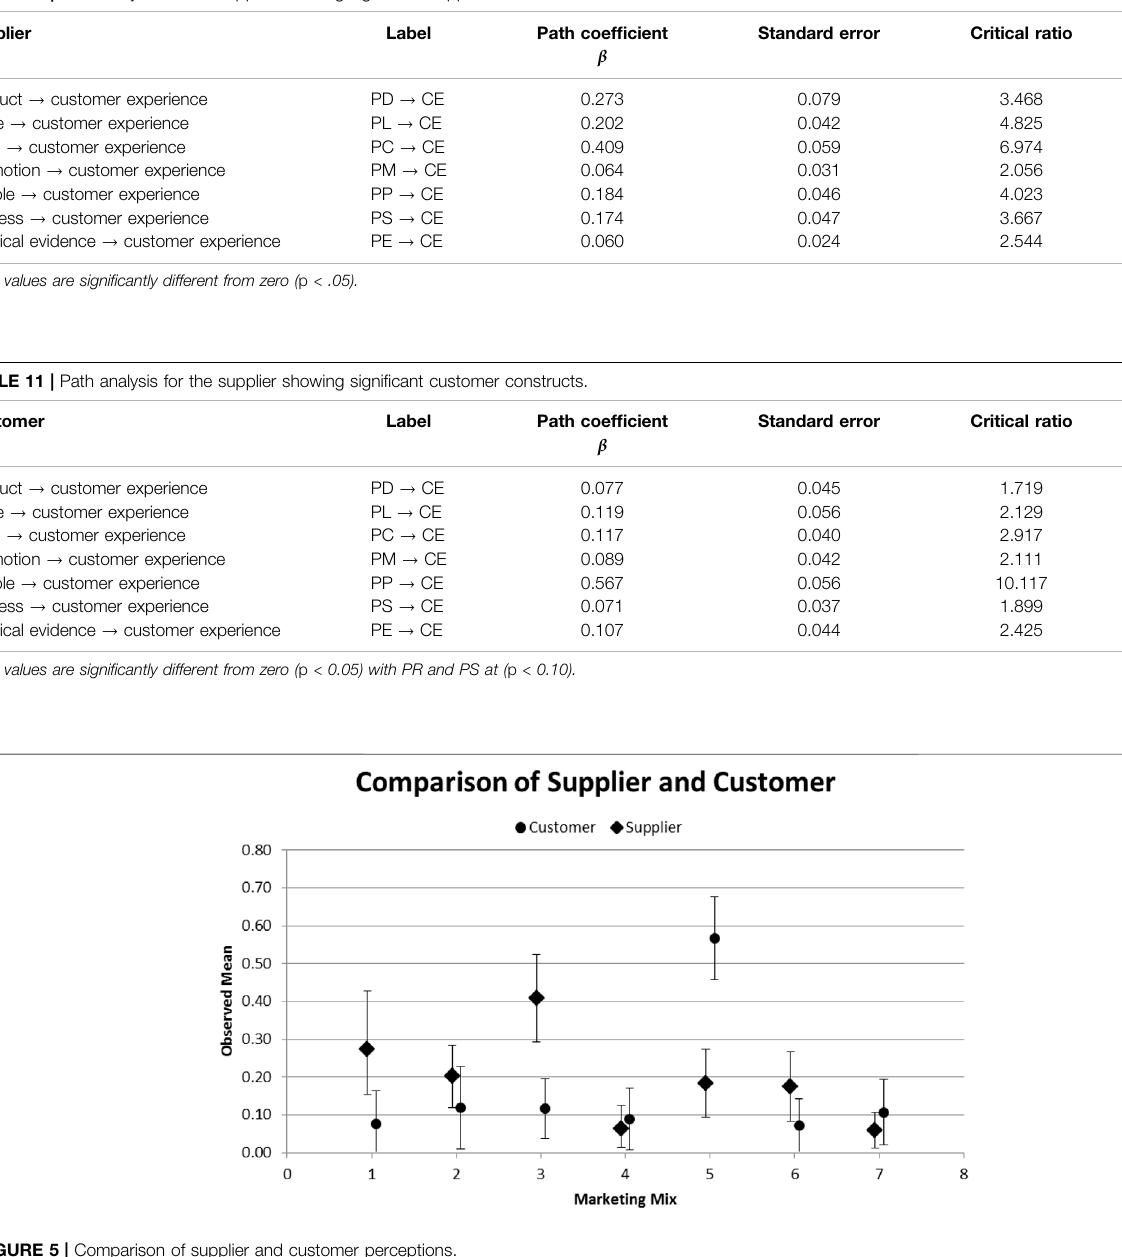
FIGURE 5 | Comparison of supplier and customer